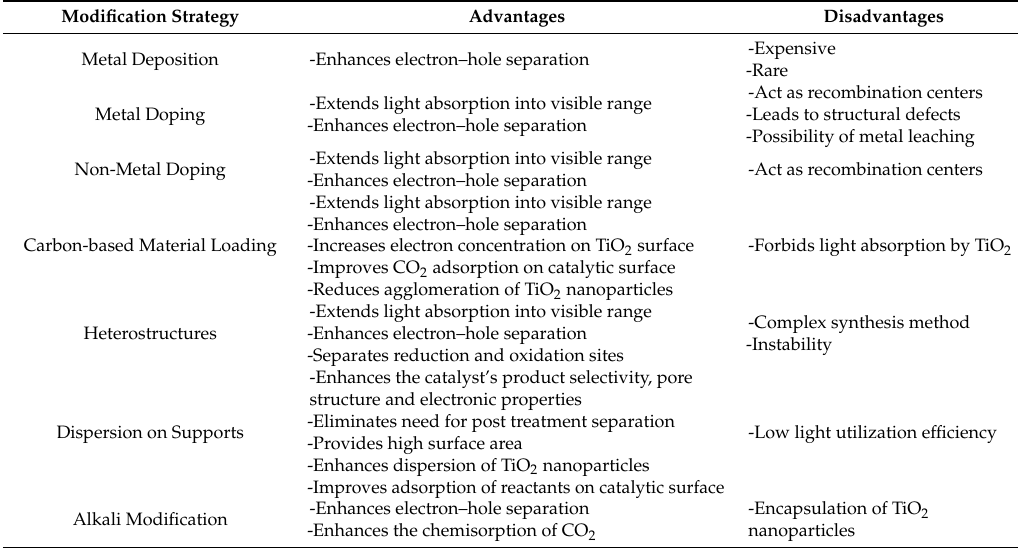
Figure 9. Photocatalyst modification strategies. Reproduced from work in [40]. Copyright 2016 Elsevier B.V. Table 1. Advantages and disadvantages of TiO 2 modification techniques.